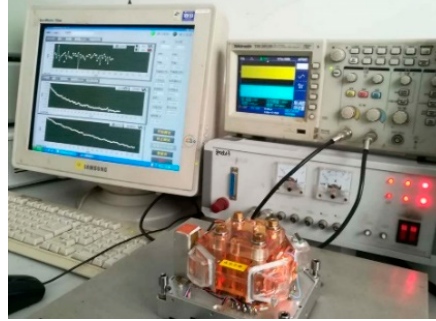
Figure 5. TRPLG used in the temperature experiment.